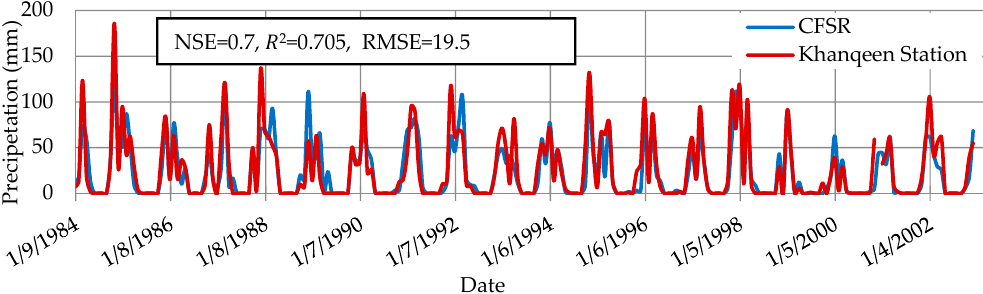
Figure 5. Correlation between CFSR and Khanaqeen gauge station for the period 1984 to 2002.